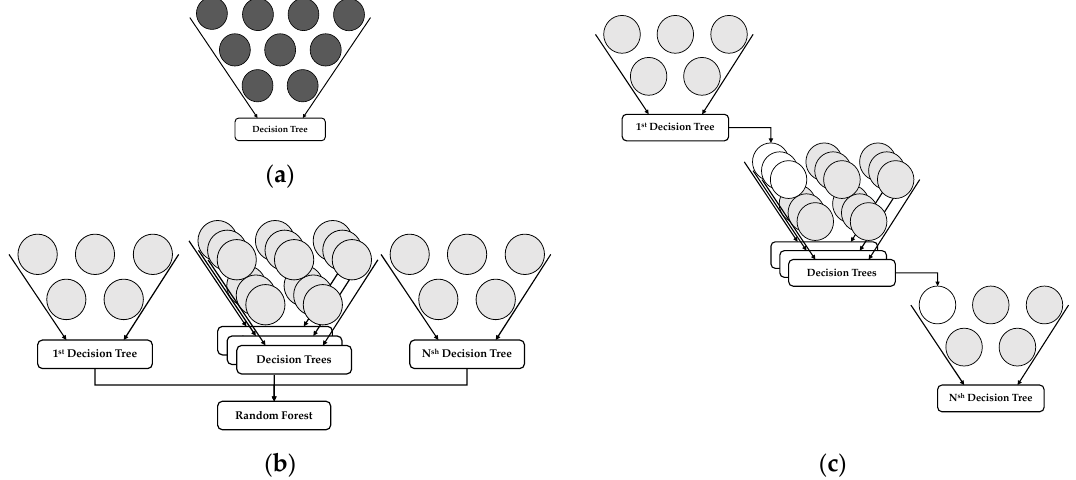
Figure 6. Representation of models. ( a ) Single tree out of all samples; ( b ) bagging grows tree parallel with subsamples; ( c ) boosting grows tree sequentially with weighted samples.